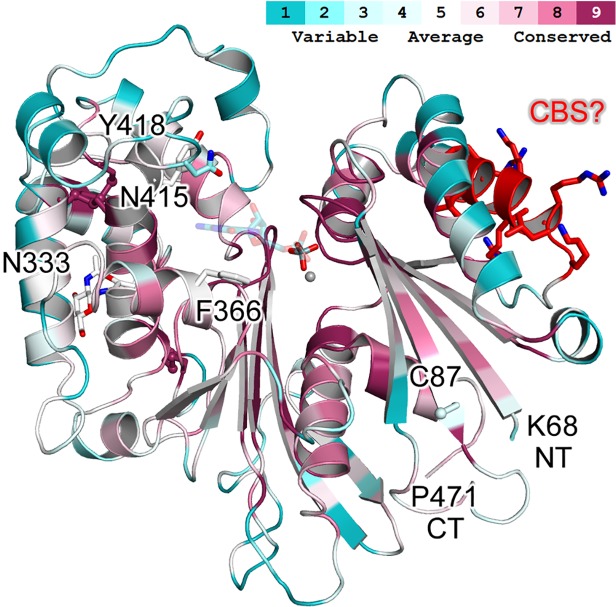
Putative three-dimensional structural model of the AtAPY1 ecto-domain.The structural model was colored using the ConSurf server [83] and 300 random NTPDase sequences sharing between 20 and 80% sequence identity. The N-terminal (NT) and C-terminal (CT) residue are marked. Three conserved cysteine bridges are predicted for the C-terminal lobe, while the non-conserved C87 is likely to be free. A single N-acetyl glucosamine group is drawn to indicate the solvent-exposed position of the single potential N-glycosylation site N333 in the back. Next to the active site Mg2+ ion (gray sphere) a vanadate ion is shown in the active site to highlight its likely competitive inhibition mechanism. The putative CaM-binding site (CBS) 169VRELLKGRSRLK180 is depicted as red sticks. An approximate binding mode for GDP is shown in half transparency. F366 and N415 are strong candidates for base sandwich binding. Y418 might be involved in base binding as well but would have to adopt a different side chain conformation than that assigned by the MODELLER program [48].